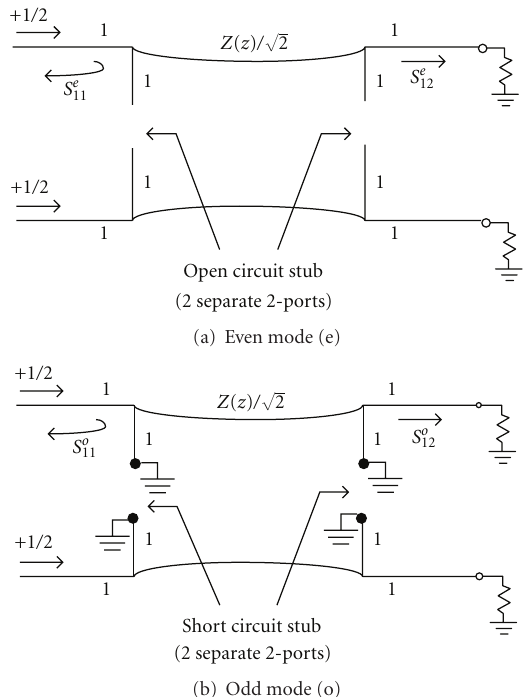
Figure 3: Decomposition of the nonuniform branch line coupler into even and odd modes of